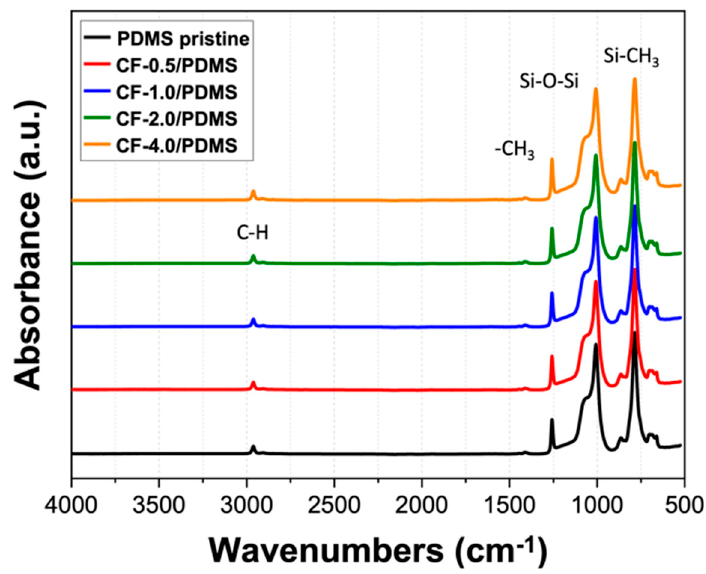
Polymers 2021 , 13 , x FOR PEER REVIEW Figure 2. FTIR spectrum of crosslinked CF filled PDMS, normalized with the Si–CH 3 peak.